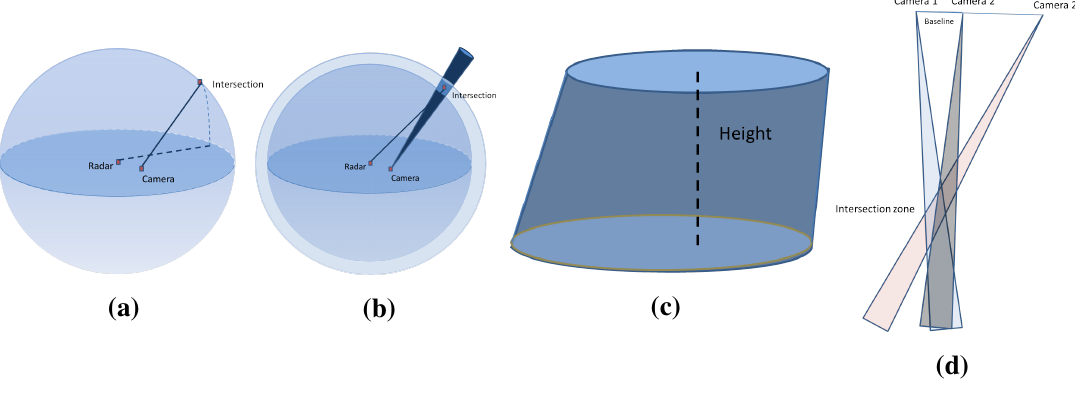
Figure 13. The intersection of the uncertainty regions of each sensor’s projection: ( a ) the ideal case of the geometric reconstruction; ( b ) introducing uncertainty regions of each sensor to the geometric model; ( c ) the error intersection region; ( d ) uncertainity intersection region in respect to the baseline for the stereo reconstruction